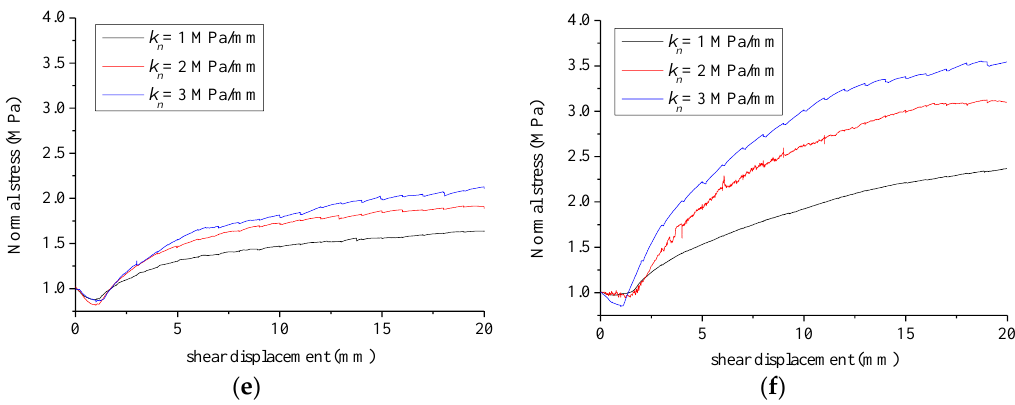
Figure 2. Shear behavior of rock fracture replicas under different normal stiffness. ( a , b ) Shear stress vs. shear displacement for the replicas G1 and G3; ( c , d ) Normal displacement vs. shear displacement for replicas G1 and G3; and ( e , f ) Normal stress vs. shear displacement for replicas G1 and G3. The relationship between normal displacement and shear displacement are shown in Figure